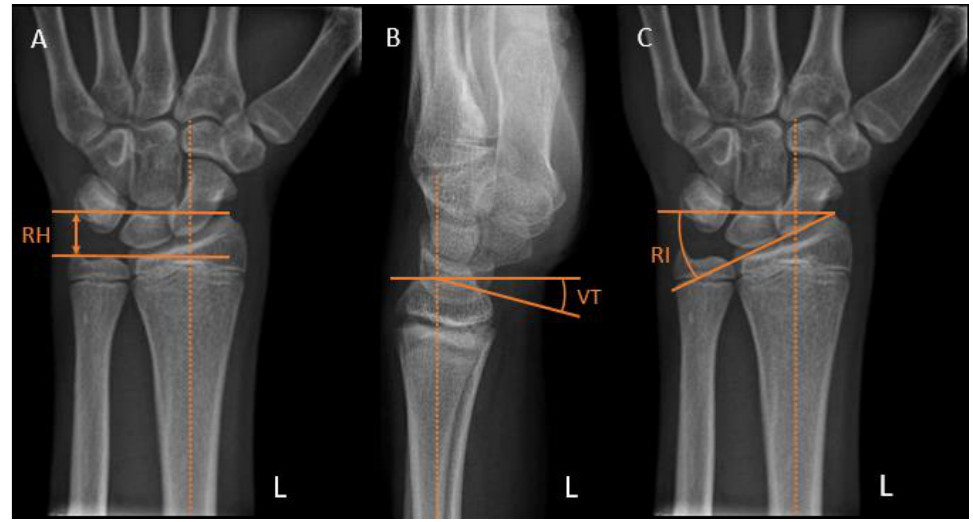
Figure 3. Distal radius radiographic reference lines. ( A ) Radial height (RH). ( B ) Volar tilt (VT). ( C ) Radial inclination (RI).